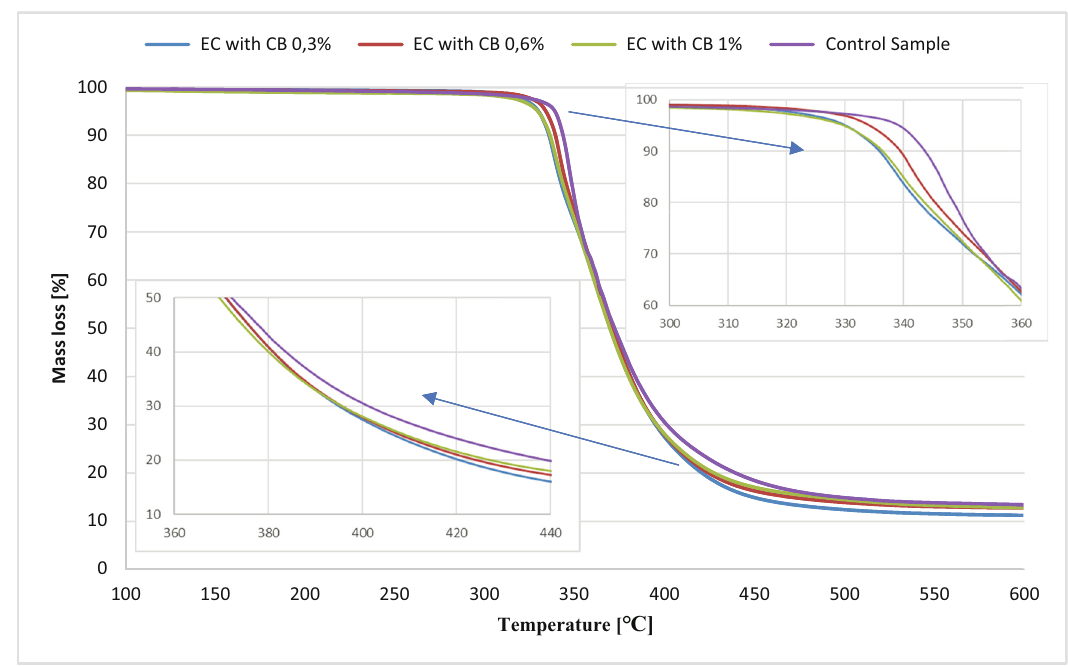
Figure 9: TGA results of Neat ( control sample ) and 0.3, 0.6 and 1 wt% carbon black added samples.